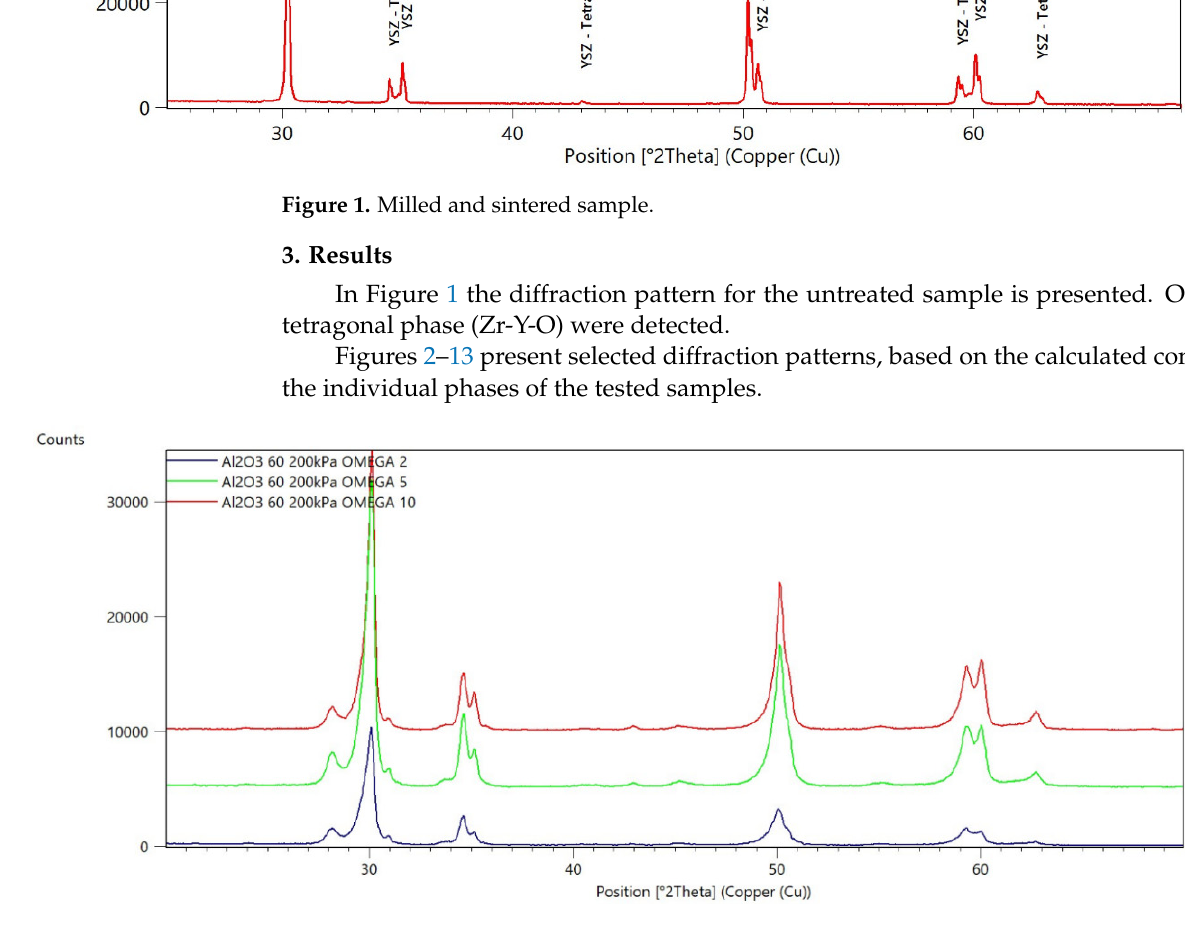
Figure 2. Diffraction patterns of sample A (abrasive—Al 2 O 3 60 μ m, pressure 200 kPa).